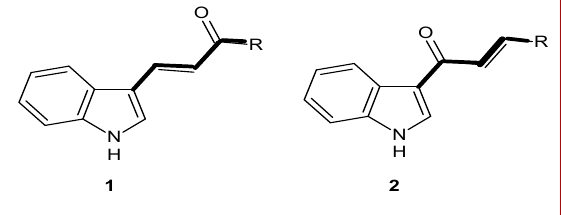
Figure 2: Skeleton of chalcone ( (cid:450), (cid:451) - unsaturated ketone) respon- sible for its biological activity